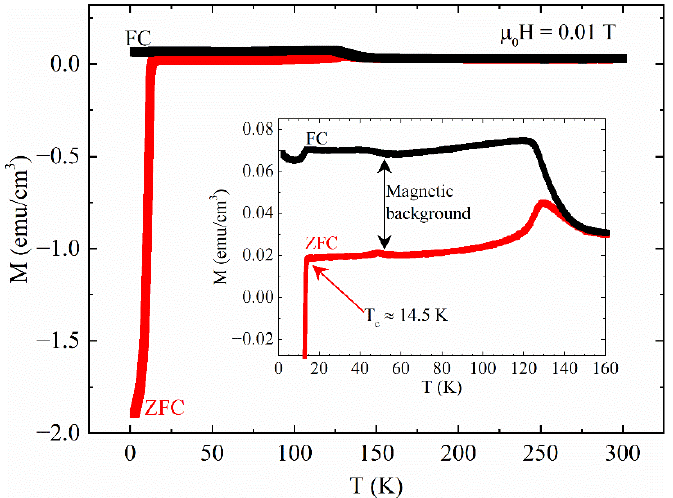
Figure 1. Magnetization as a function of temperature M(T) measured in ZFC-FC conditions with an applied magnetic field µ 0 H = 0.01 T. Inset: a magnification of the temperature region between 0 K and 160 K shows the presence of a magnetic background. The red arrow indicates the T c of the sample.